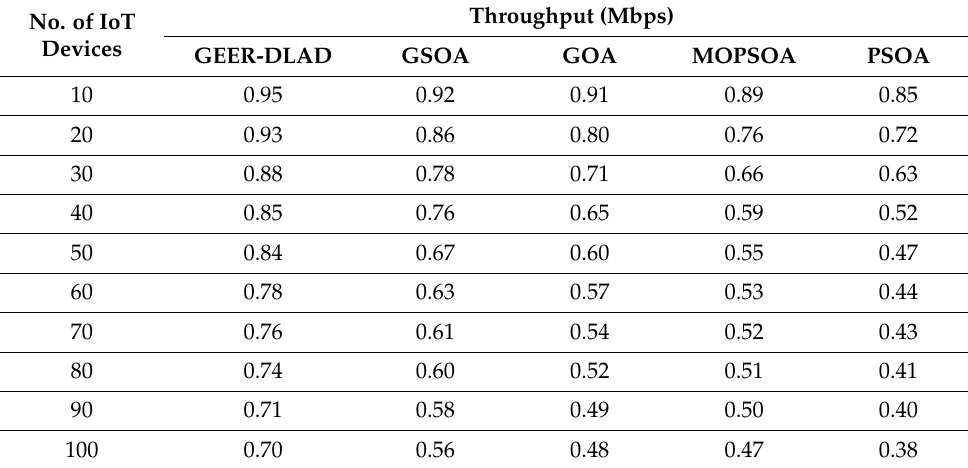
Table 3. The Result Analysis of Existing with Proposed GEER-DLAD Method in terms of Throughput (Mbps).